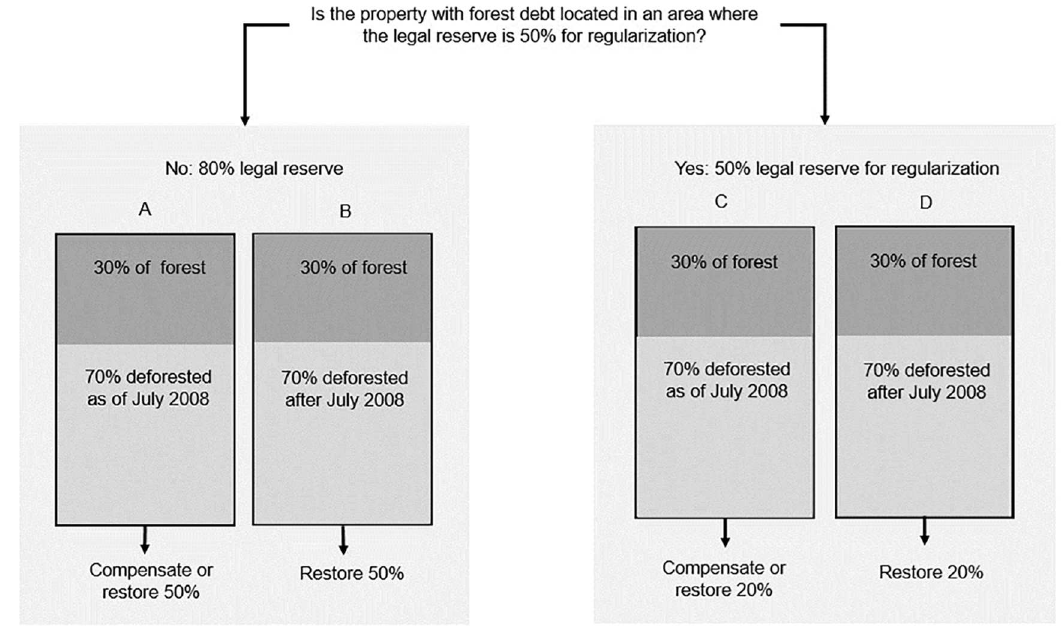
Fig 1. Examples of the legal reserverules for properties deforested before and after July 2008. This example appliesfor medium and larger properties, since small properties(up to 64 hectares in averagein Para´ State) do not need to restore or compensate legal reserve deforested as of 2008. Property A and C have a pre-2008legal reserve debt, but only propertyA is located in a regionwhere the legal reserve can be reducedto 50% for regularization purposes.The landowner of property A needsto regularize50% of the property with compensation or restorationto reach a 80% legal reserve, while propertyC needsa 20% regularization to reach a 50% legal reserve. PropertiesB and D have a post-2008 legal reserve debt, but in both cases their landownerscan only restore the deforested